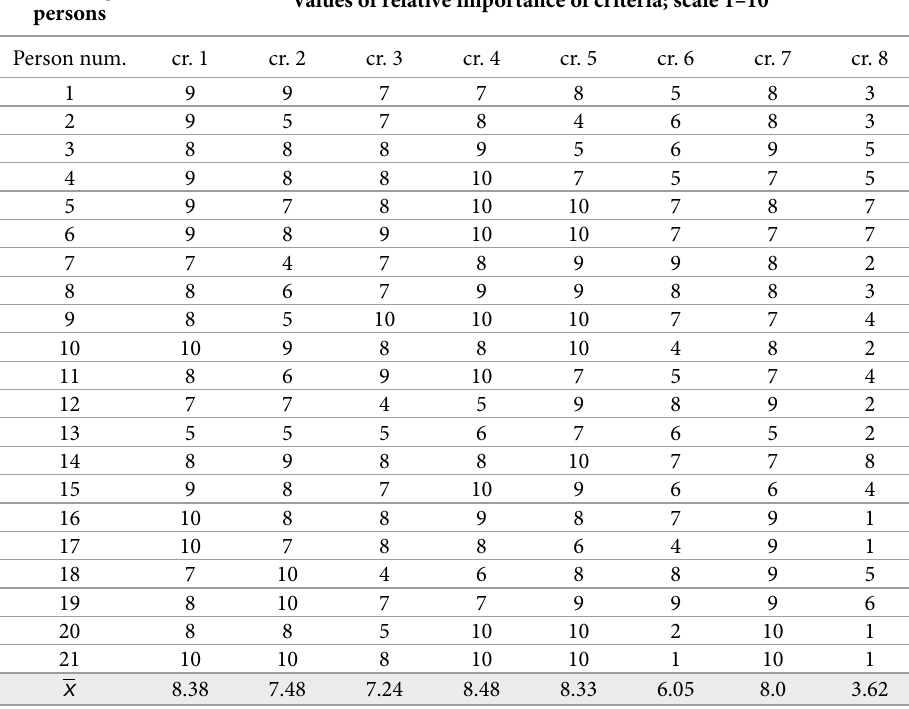
Table 1. Values of relative importance of criteria defined by the group of 21 people. Assessing Values of relative importance of criteria; scale 1–10 persons Person